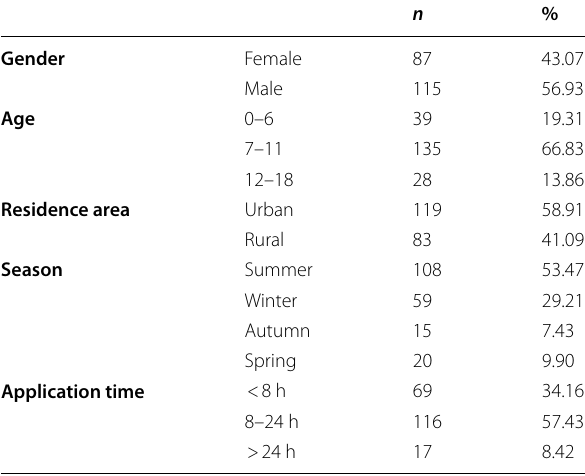
Table 1 Descriptive information of the patient